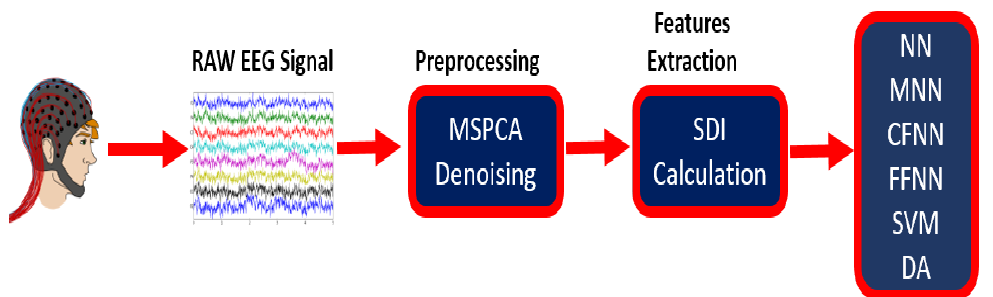
Figure 1. Block diagram of the successive decomposition index for identification of motor and mental imagery